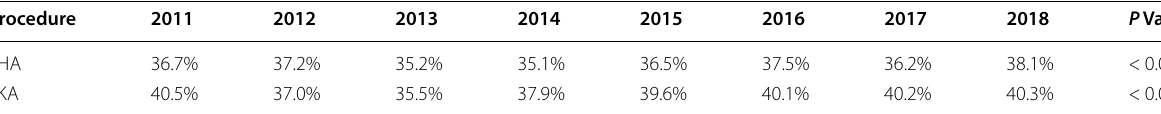
Table 3 Utilization rates of spinal anesthesia between 2011 and 2018